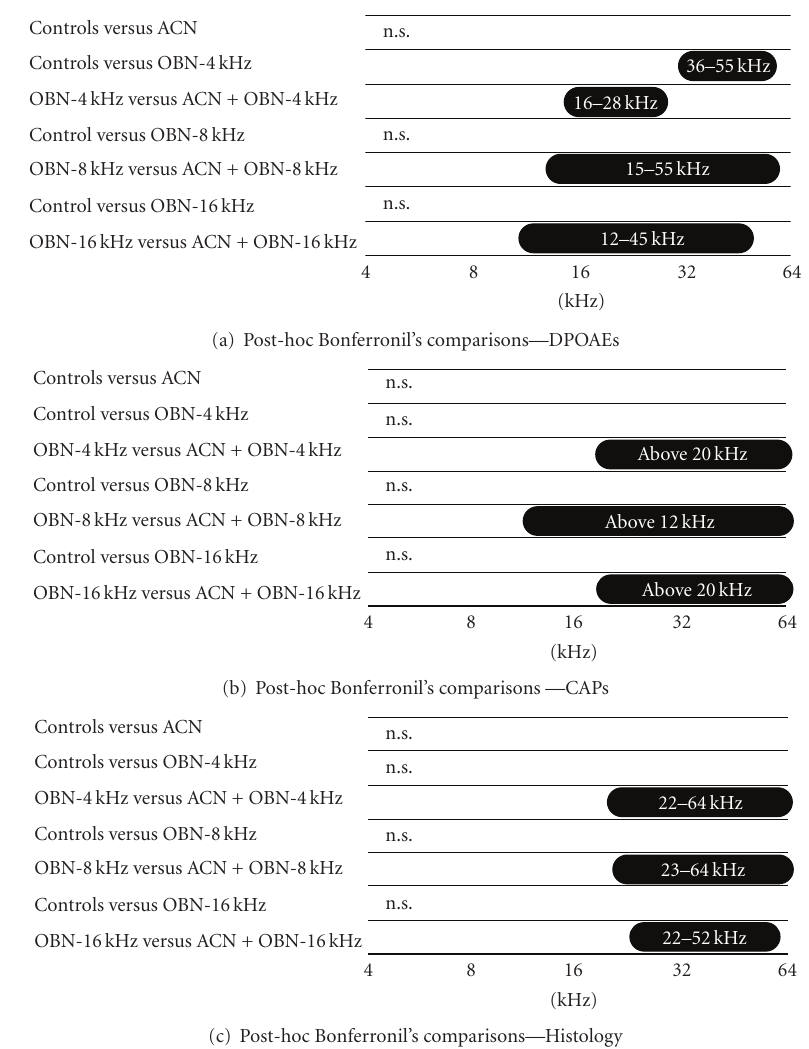
Figure 5: Statistical comparisons between groups for (a) DPOAE amplitudes, (b) CAP thresholds, and (c) hair cell loss at 4 weeks postexposure: Bonferroni’s post-hoc comparisons with P = . 05 as the significant limit. The parent analyses were repeated measure ANOVAs with “exposure” as between factor and “frequency” as a within factor. The colored bands illustrate the frequency range for which Bonferroni’s comparisons between groups yielded P < . 05. ns: not significantly di ff erent. Note: for the CAP technique, the significance range is presented as “above xkHz” because it does not allow measurements above 40 kHz, whereas the significance is likely more extended toward high frequencies